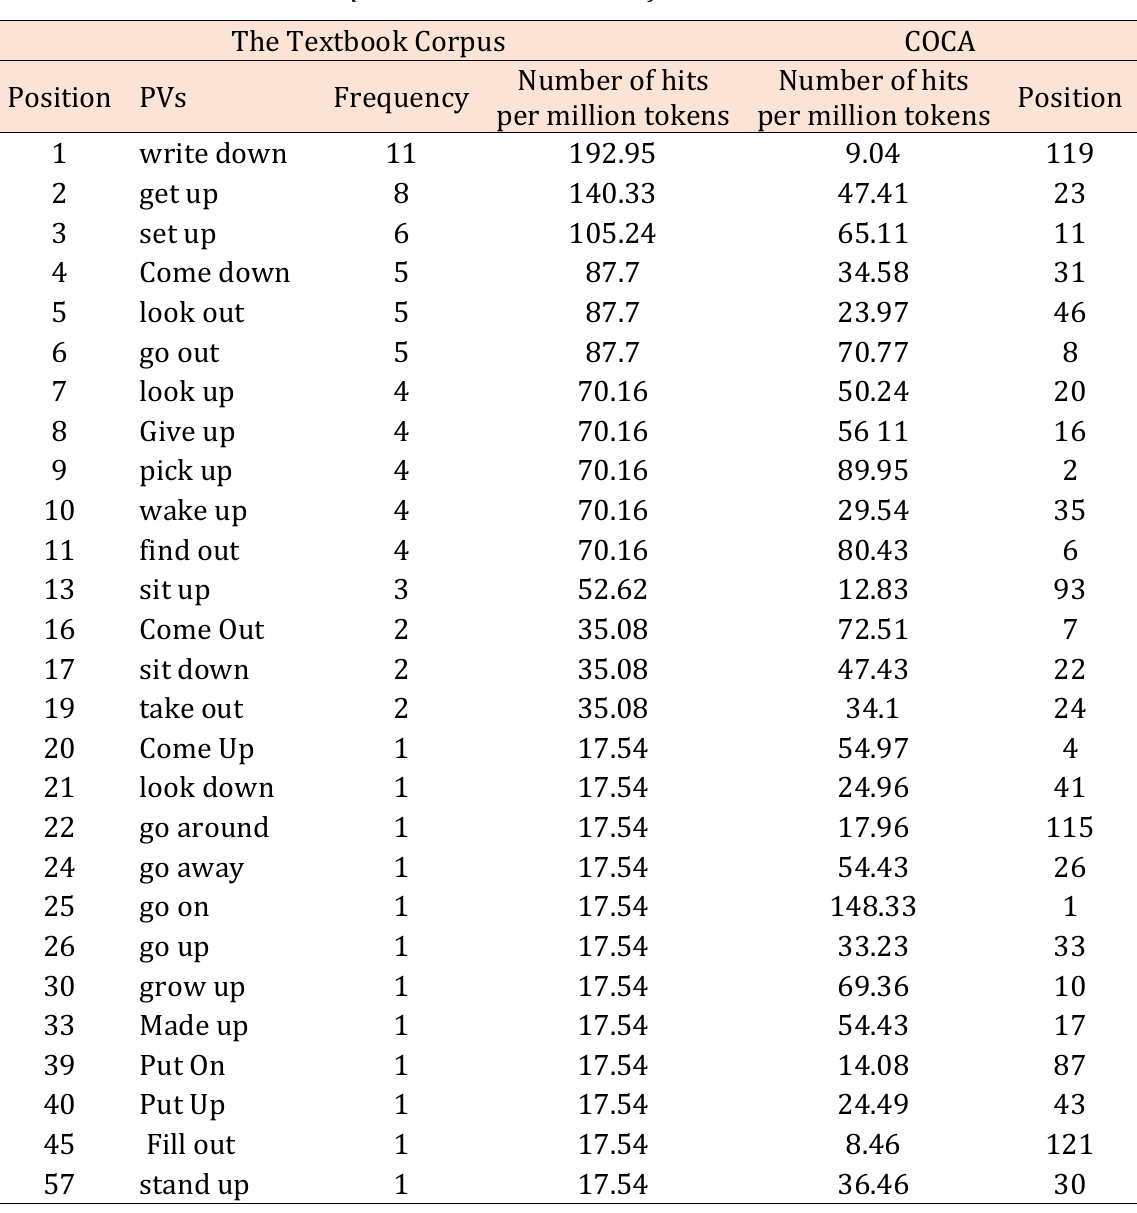
Table 5. The Comparison between the PVs of the Textbook and the